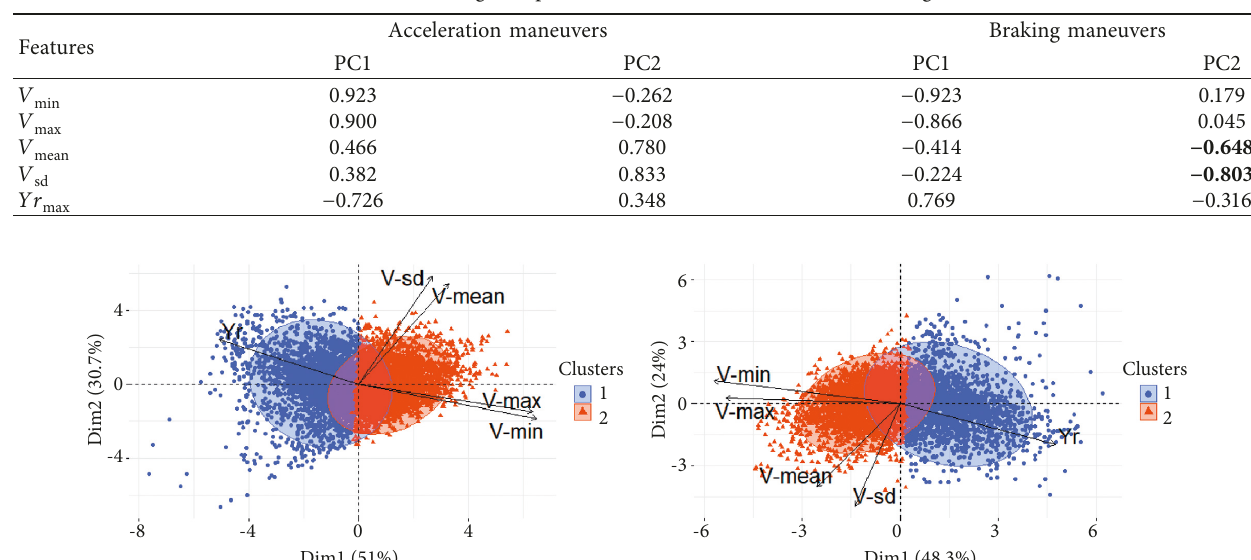
Figure 7: Silhouettes of (a) Speed_acceleration clusters (b) Speed_braking Table 7: The PC loadings of speed variables for acceleration and braking datasets.